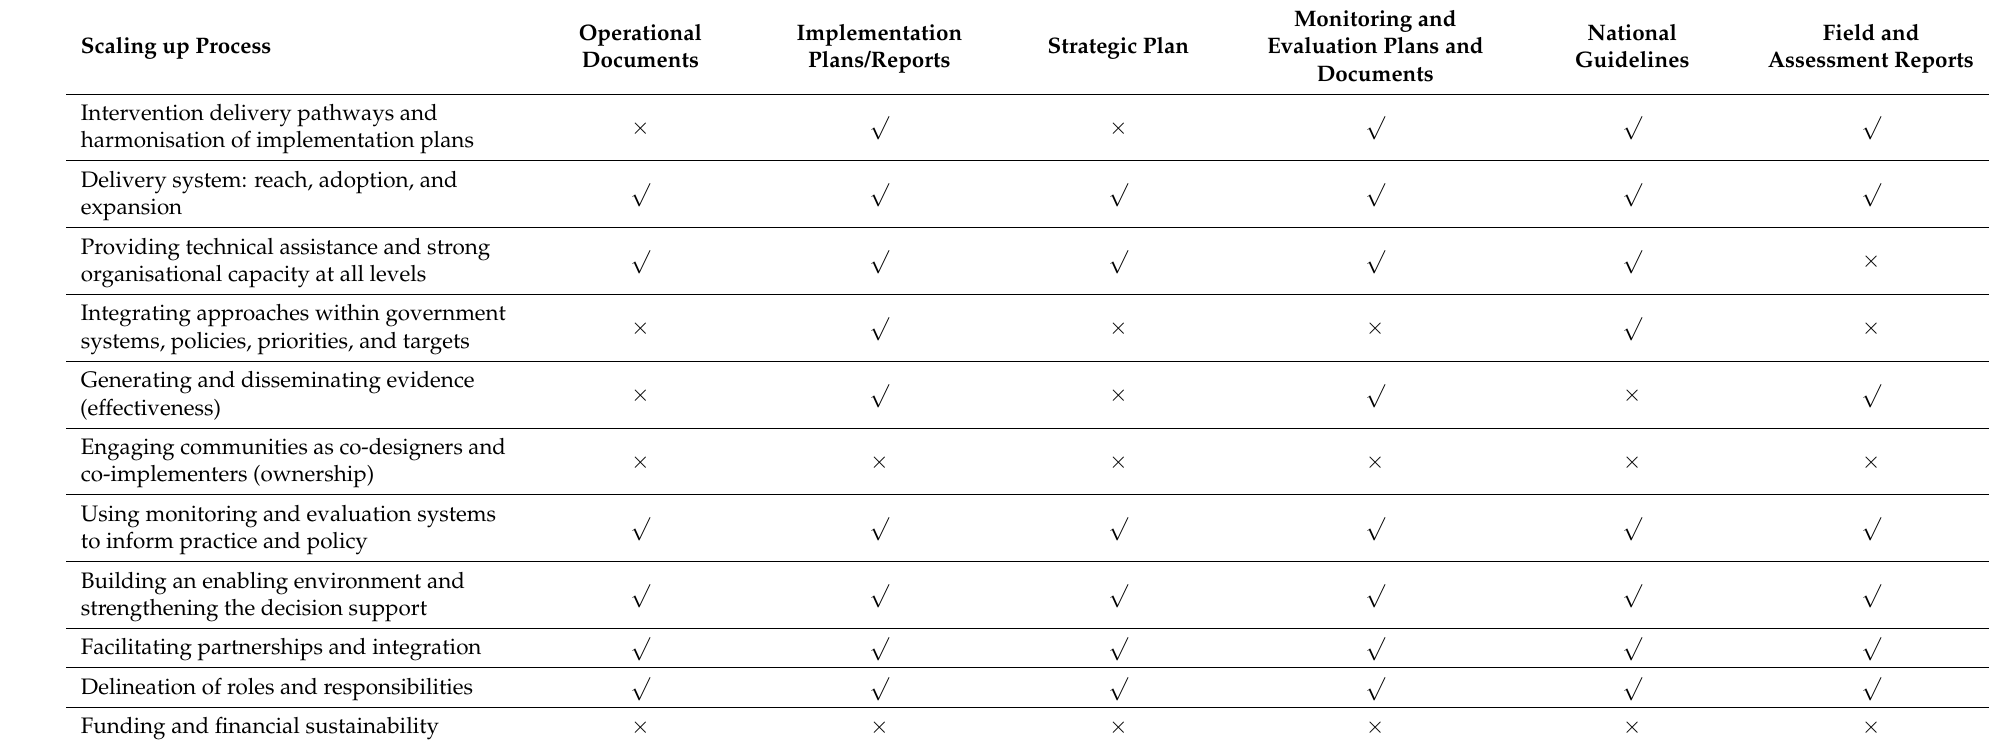
Table 1. Enablers of stabilisation centres and OTPs’